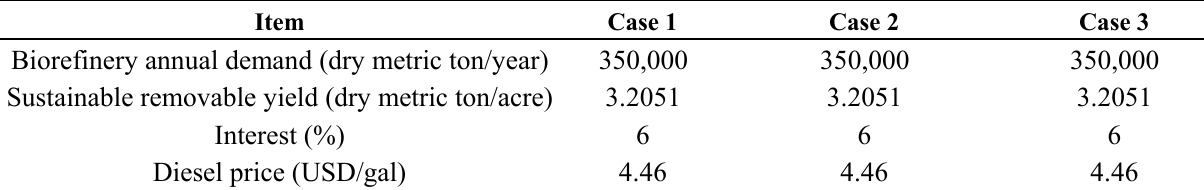
Table A1. Equipment and other elements used during harvesting and